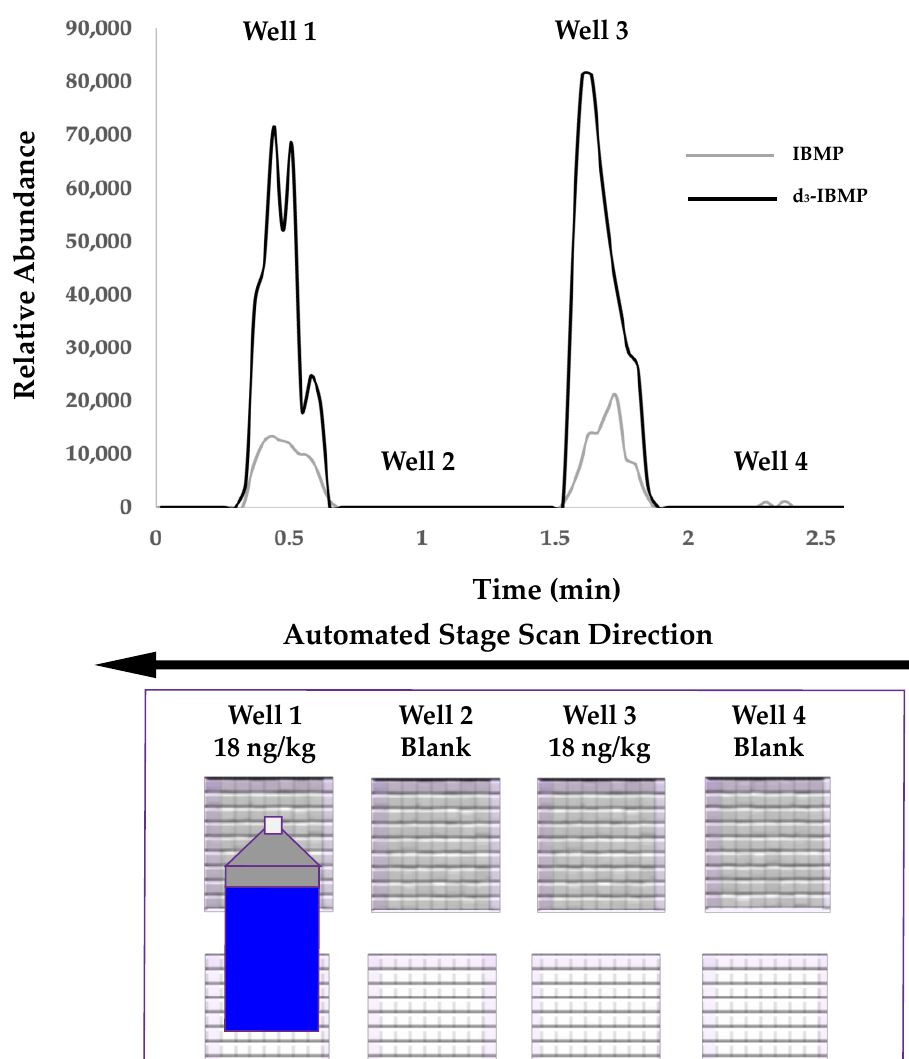
Figure 3. DART-Orbitrap-MS/MS selected ion chronograms for IBMP ( m/z 167.1427 ➔ m/z 124.0632)